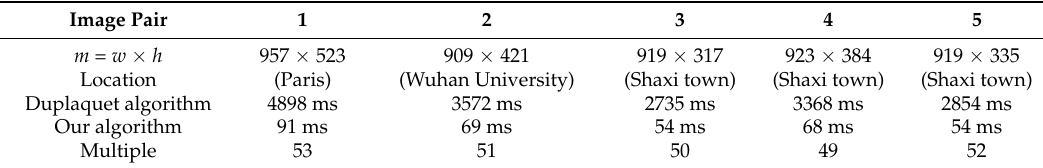
Table 1. Compared time efficiency of energy accumulation